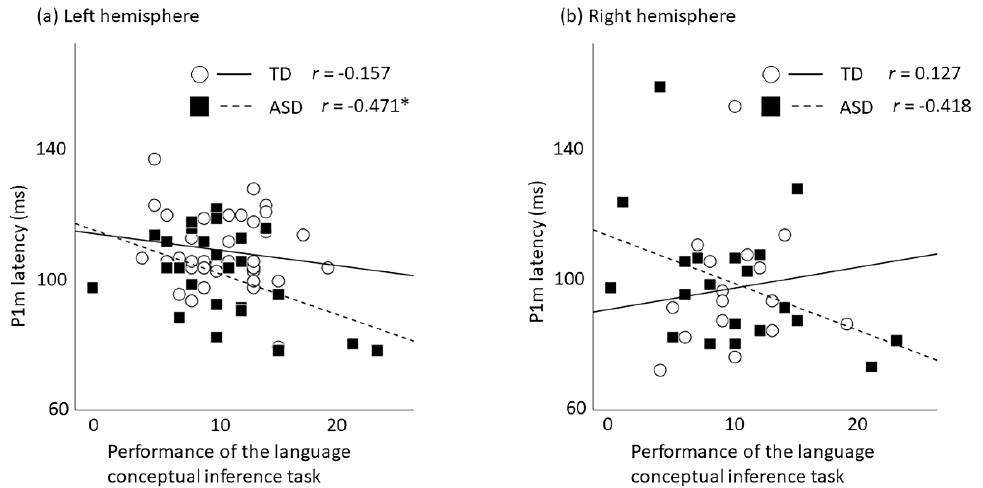
Figure 2. Scatter plot of the P1m latency and the performance of language conceptual inference in both groups. For children with ASD, a shorter P1m latency in the left hemispheres was associated with a higher performance on the language conceptual inference tasks ( p = 0.015) ( a ). The correlation was not statistically significant in the right hemisphere ( p = 0.067) ( b ). No significant correlation between the P1m dipole latency and the performance on the language conceptual inference tasks for children with TD: solid line, regression line for children with TD; broken line, regression line for children with ASD. * p < 0.025.